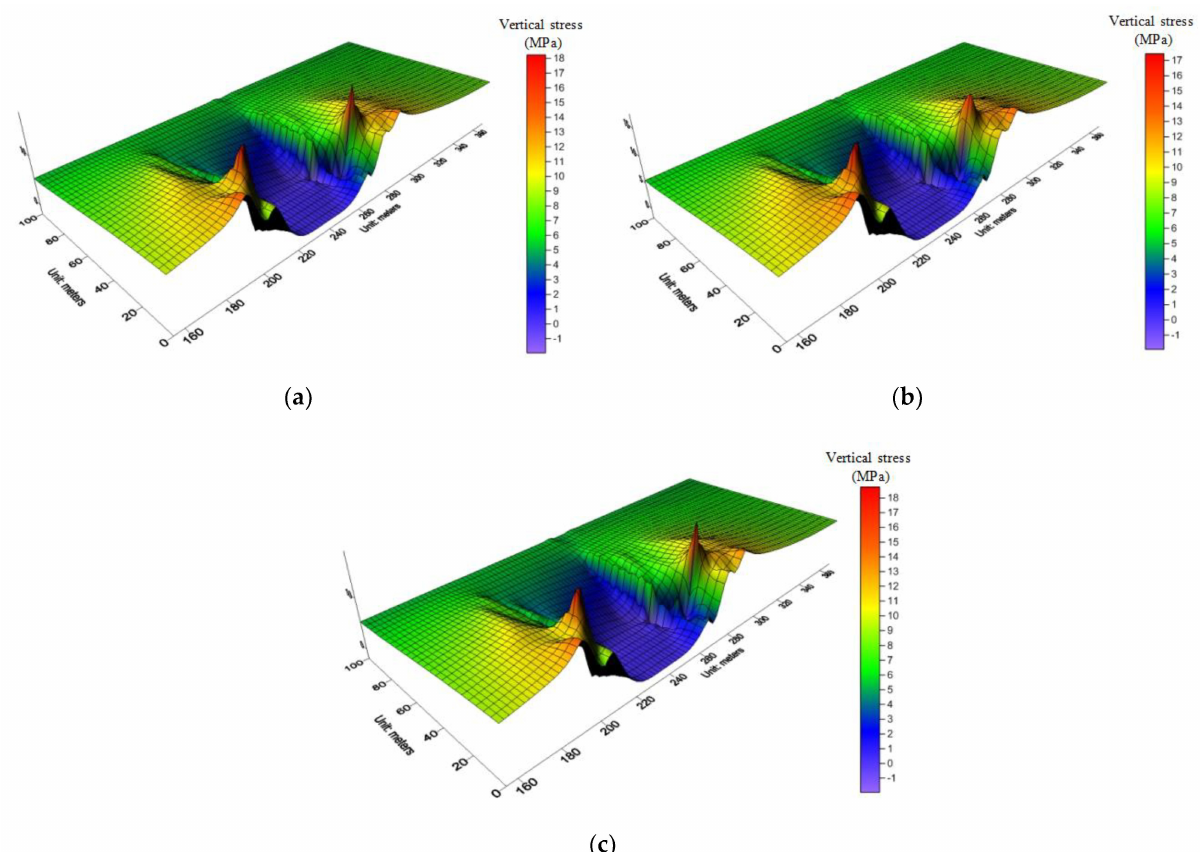
Figure 10. Three-dimensional (3D) curved surface of vertical stress of coal pillars of different sizes: ( a ) the width of the coal pillar is 4 m; ( b ) the width of the coal pillar is 5 m; ( c ) the width of the coal pillar is 6 m.